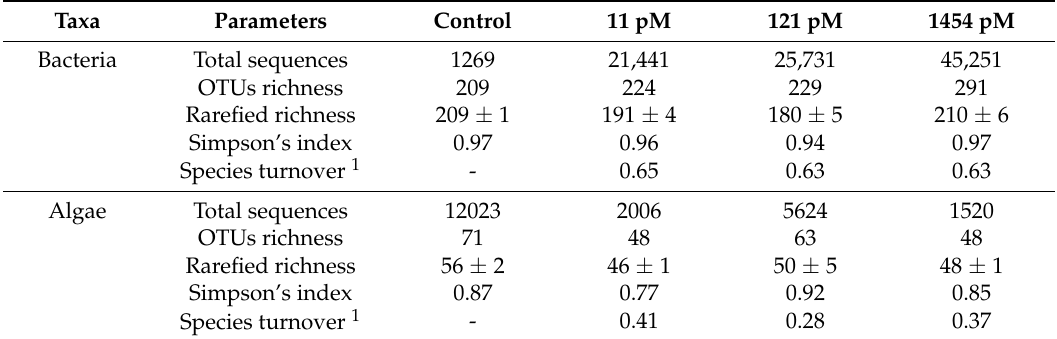
Table 1. Total sequences, OTUs and rarefied richness, Simpson’s diversity index and species turnover for bacteria and microalgae communities in biofilms grown without Hg addition (control), in 11 ± 2 pM, 121 ± 9 pM and 1454 ± 54 pM